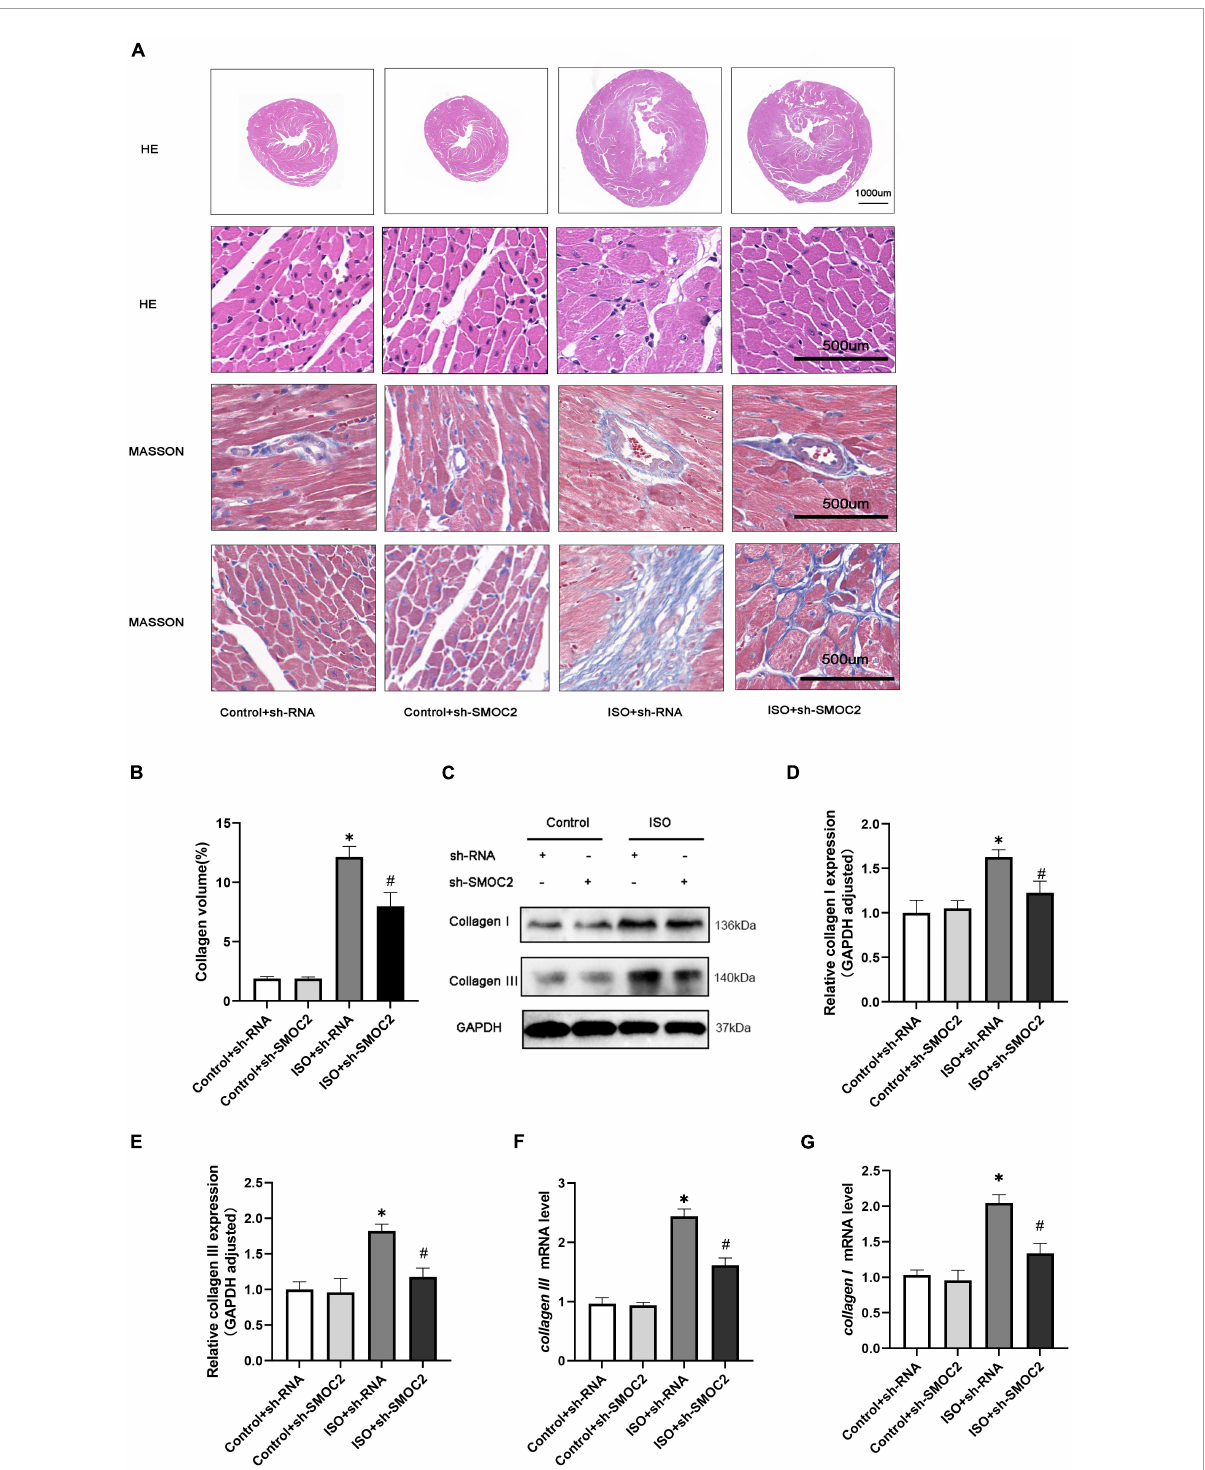
FIGURE3 SMOC2 knockdown partially reversed the myocardial fibrosis in response to ISO Stimulation in vivo . (A,B) Representative images of HE and Masson staining and quantified analysis ( n = 6). (C–E) Representative images of Western blots and the quantitative data ( n = 6). (F,G) The relative mRNA levels of Collagen I, Collagen III ( n = 3). ∗ p < 0.05 vs. the control + sh-RNA group. # p < 0.05 vs. the ISO + sh-RNA group. n.s.,